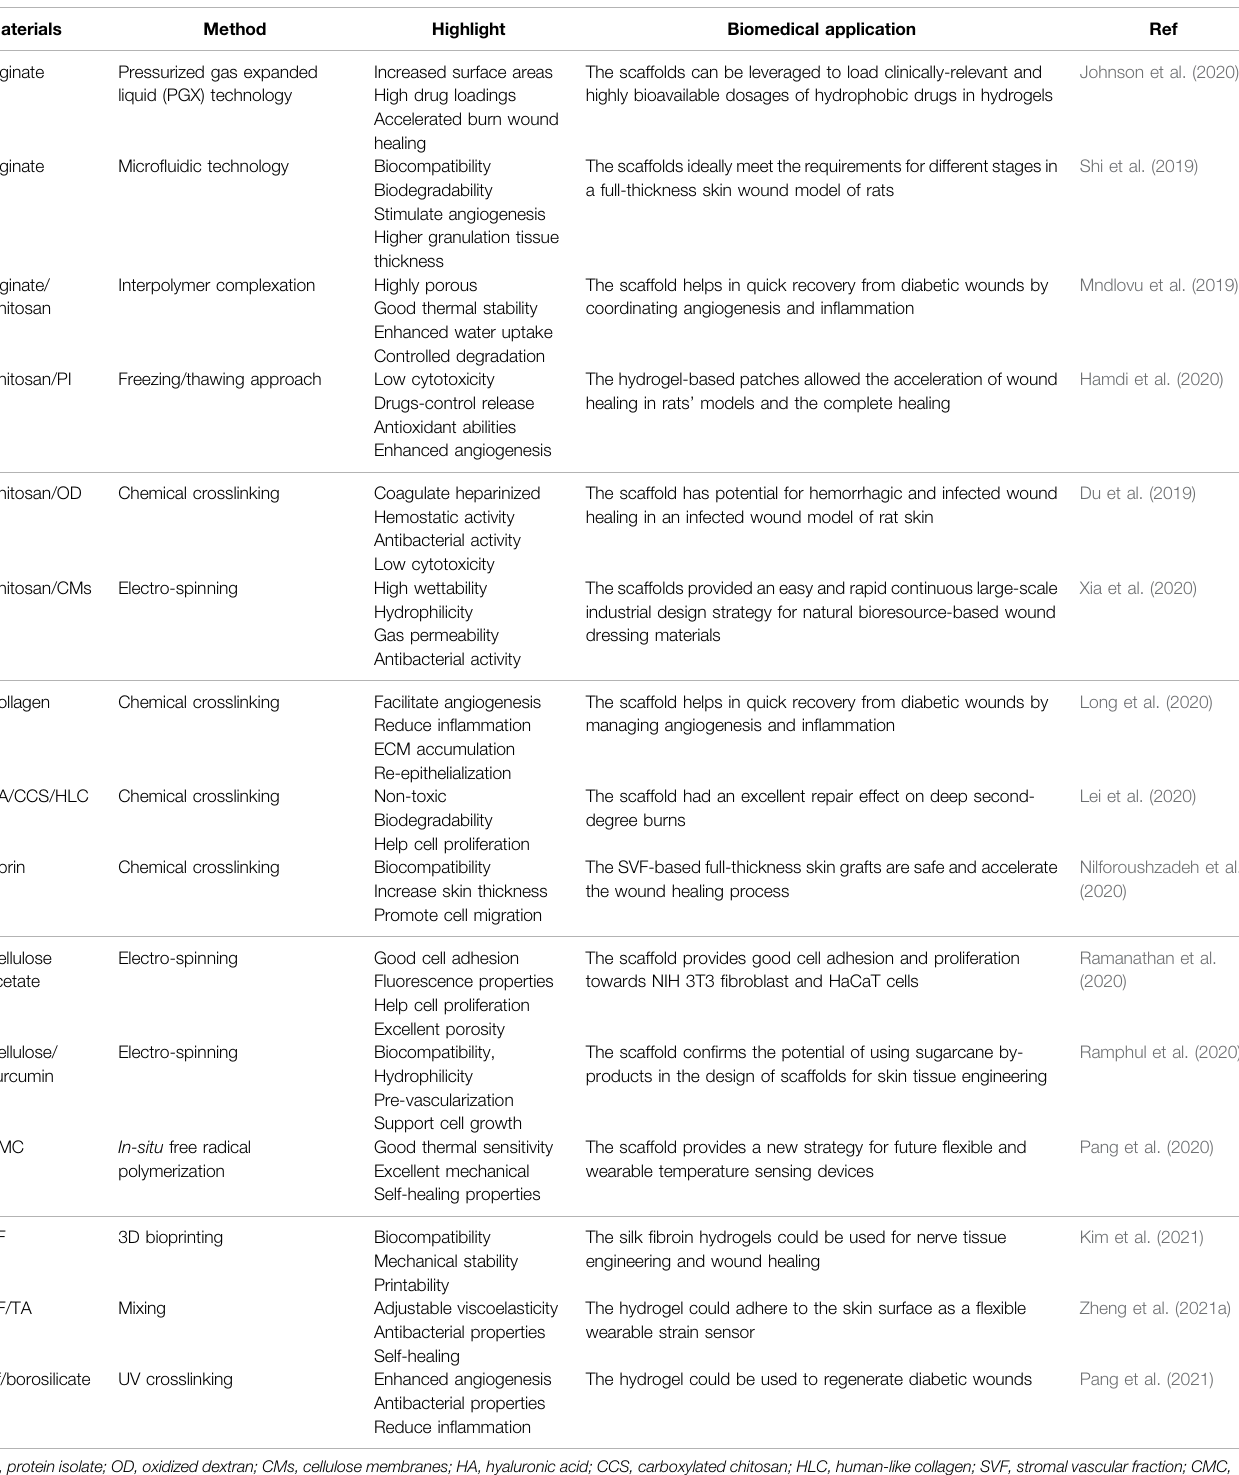
TABLE 1 | Natural biomaterials of bioengineered